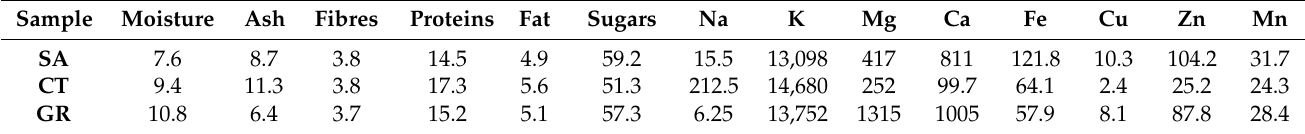
Table 2. Nutritional table. Physical parameters, nutritional and chemical element content of dried stigmas of SA, CT, GR saffron samples (see Material and methods). Data are expressed as percentages (physical parameters and nutritional compounds) and mg/kg (chemical elements). Data are the mean of three determinations (standard deviation <2%). Sample